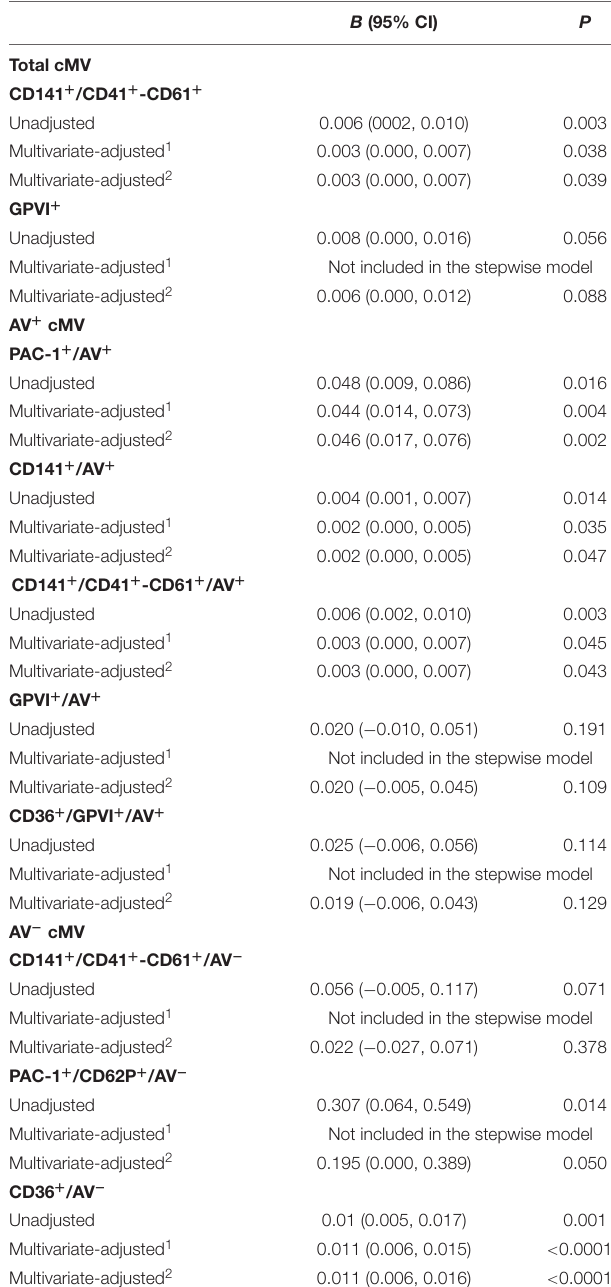
TABLE 2 | Association between cMV from different phenotypes and successful